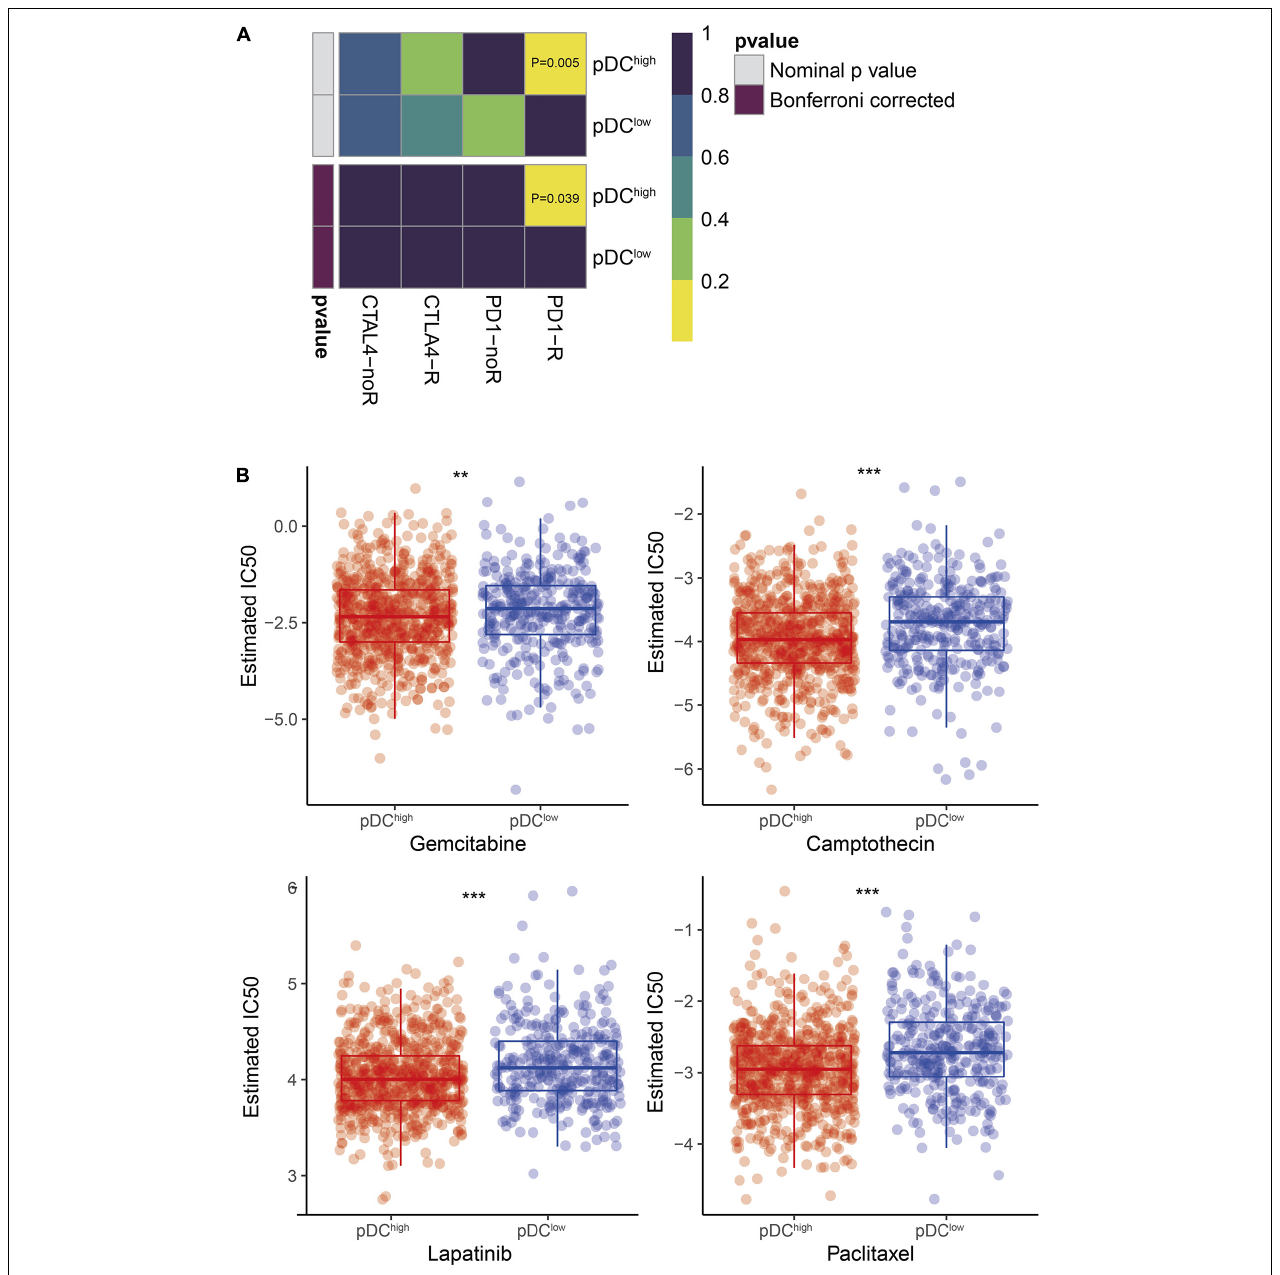
FIGURE 7 | Differential putative immunotherapeutic and chemotherapeutic response prediction. (A) Submap analysis in two groups. (B) The box plots of chemotherapeutic response in two groups. The meaning of the statistical difference is as follows: ** represents p ≤ 0.01 and *** represents p ≤